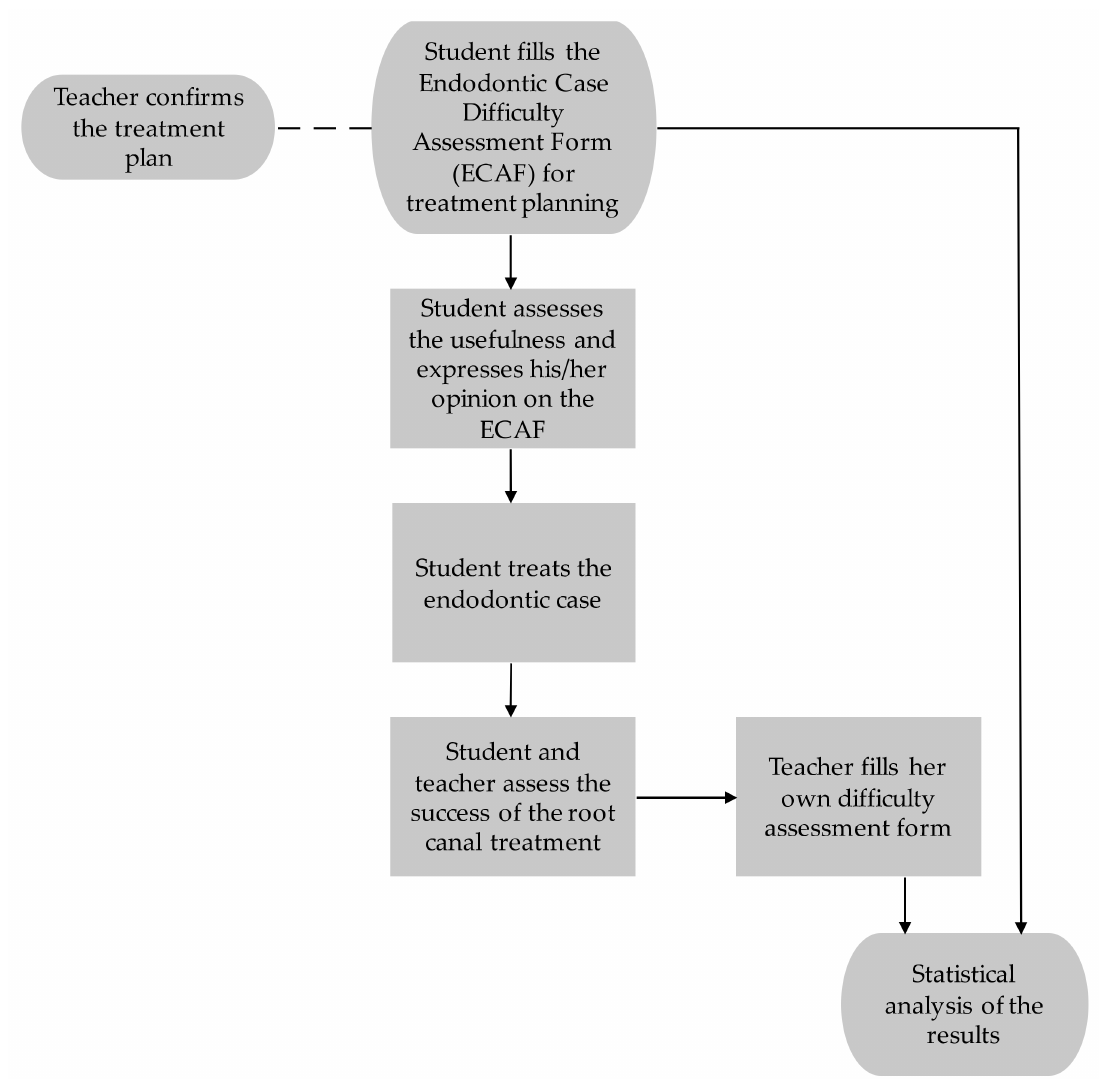
Figure 1. The protocol of the research